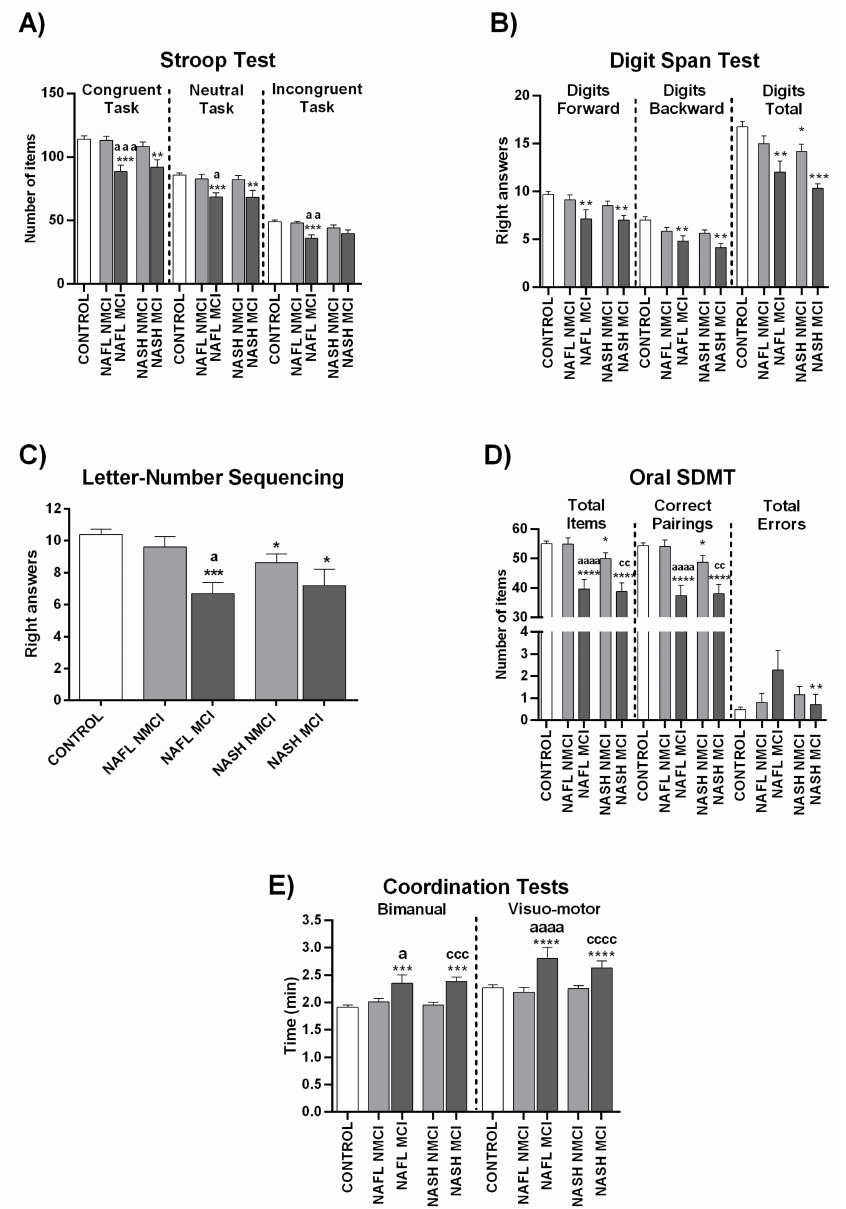
Figure 5. Performance in different psychometric tests of NAFL and NASH patients classified by the new score as with (MCI) or without (NMCI) mild cognitive impairment. ( A ) Results of Congruent (number of words), Neutral (number of colors), and Incongruent (number of items completed) tasks in Stroop test. ( B ) Results of the two tasks of Digit Span test (Digits forward and digits backward), and total Digits score. ( C ) Right answers in Letter-Number Sequencing test. ( D ) Performance in Oral SDMT test. ( E ) Time (min) in Bimanual and Visuo-motor coordination tests. Results are the mean ± SEM. * p < 0.05; ** p < 0.01; *** p < 0.001; **** p < 0.0001 vs. control group (CNT), a p < 0.05; aa p < 0.01; aaa p < 0.001; aaaa p < 0.0001, NAFL MCI vs. NAFL NMCI; cc p < 0.01; ccc p < 0.001; cccc p < 0.0001, NASH MCI vs. NASH